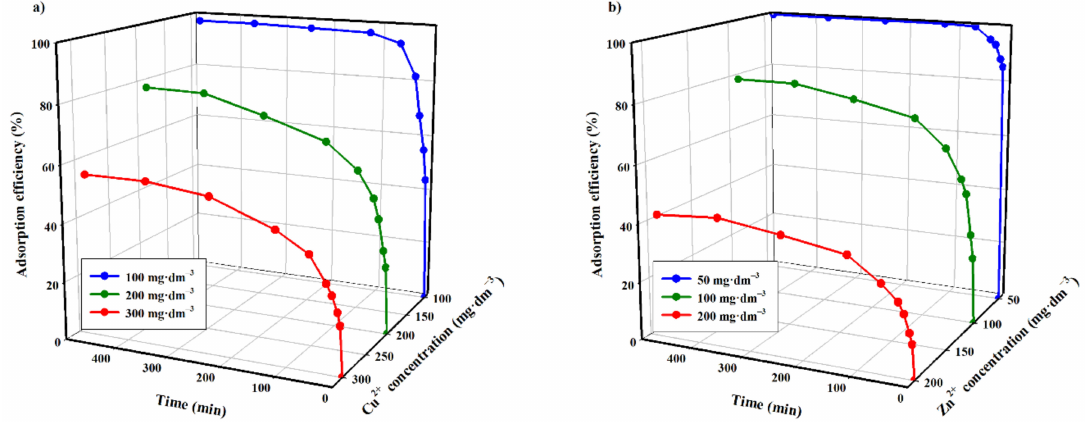
Figure 10. Adsorption efficiency as a function of time and initial concentration ( a ) copper(II); ( b ) zinc(II) (T = 313.15 K, mass of adsorbent = 3.33 g · dm − 3 , pH =